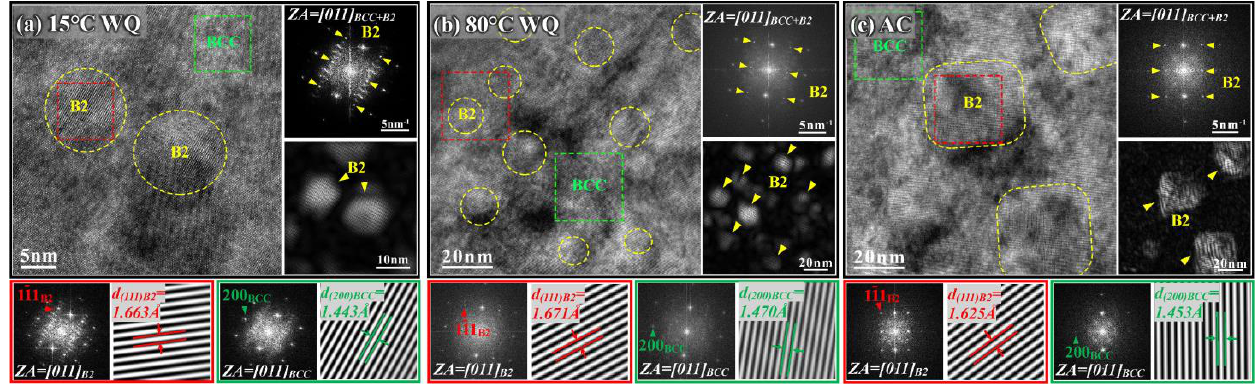
Figure 6. HRTEM images, FFT images and FFT filtered images for the solution-treated 8Ni2Mo alloy subjected to 15 °C WQ ( a ), 80 °C WQ ( b ) or AC ( c ). Note that the results in the red and green solid box were from the corresponding red and green dashed areas in the HRTEM images, respectively. Table 2. Average diameters, lattice constants and misfits of B2 nano-particles in Fe-Mn-Al-Ni-Mo SMAs subjected to different cooling methods.